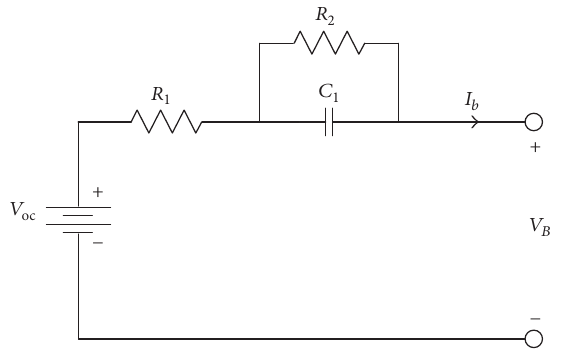
Figure 1: Battery electrical